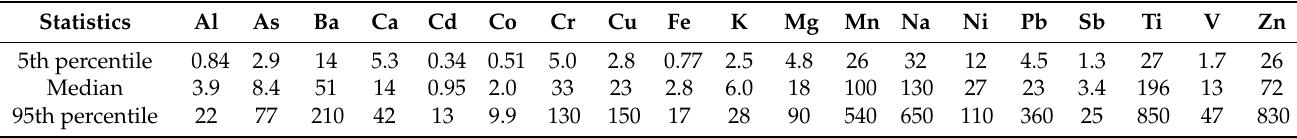
Table 1. Descriptive statistics of the element concentrations obtained from the direct digestion of all PM 10 samples collected in 2015. All the values are expressed in pg/m 3 except Al, Ca, Fe, K, Mg and Na, which are expressed in ng/m 3 .